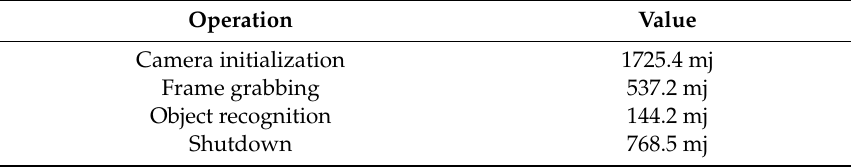
Table 4. Basic energy expenditure of sensor